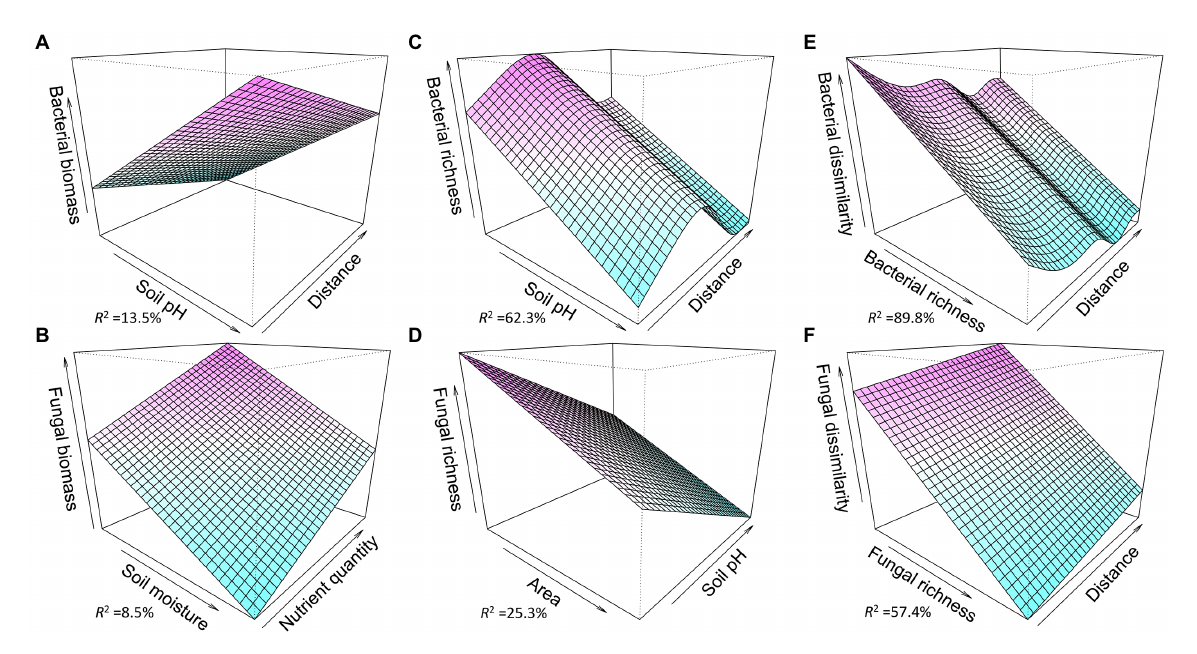
FIGURE 5 Fitted relationships between soil microbial variables (biomass, richness, and dissimilarity) and explanatory variables across the three island types based on generalized additive models. Bacterial biomass (A) and bacterial richness (C) were explained by distance and soil pH; fungal biomass (B) was explained by soil moisture and soil substrate quantity; fungal richness (D) was explained by island area and soil pH; bacterial dissimilarity (E) and fungal dissimilarity (F) were explained by their richness and distance to mainland. The detailed results of generalized additive models were showed in Supplementary Table